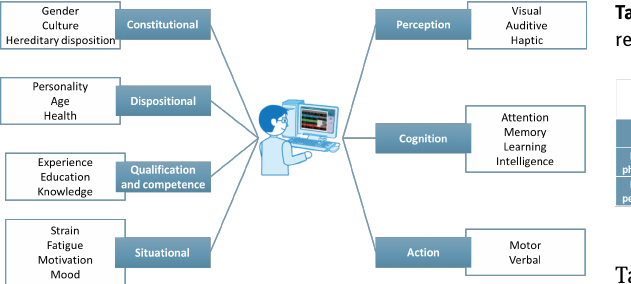
Figure 2: Human characteristics and capabilities influencing the interaction with socio-technological systems [18].